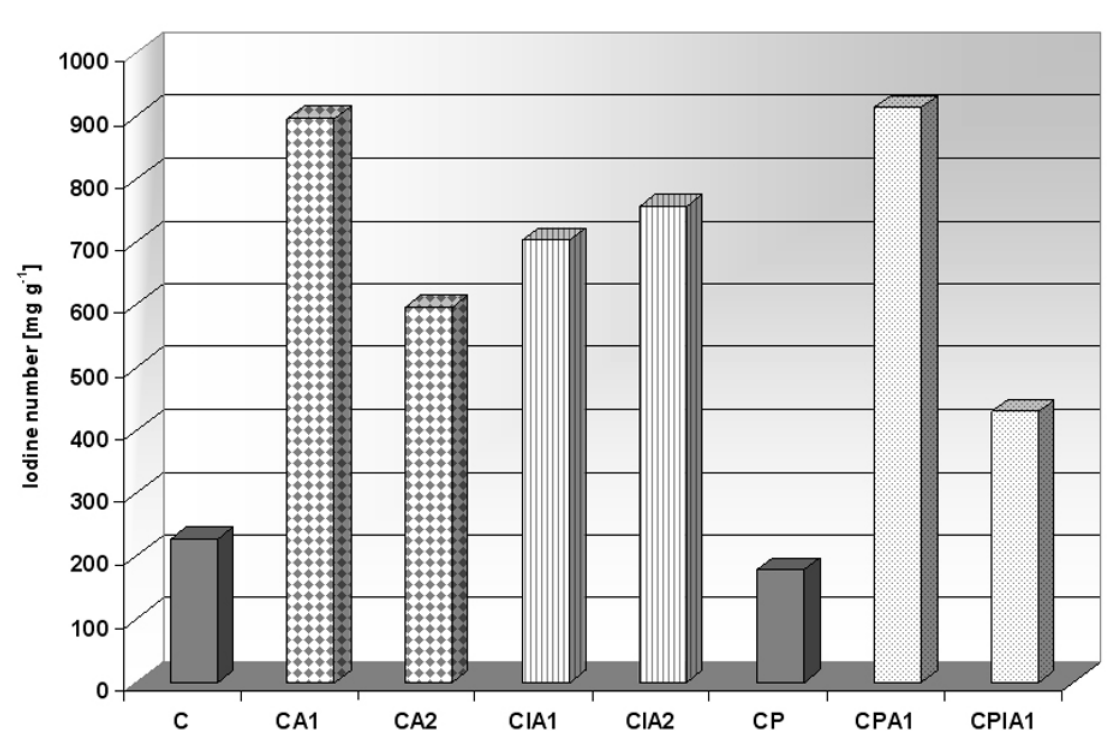
Figure 3. Iodine number for initial sample, char and activated carbons